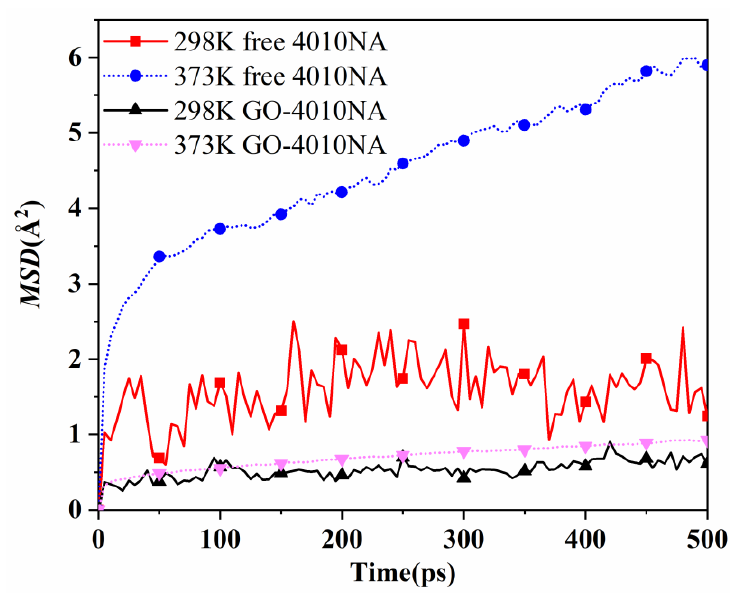
Figure 13. The MSD curves of 4010NA and GO-4010NA in NBR composites at different tempera- tures.